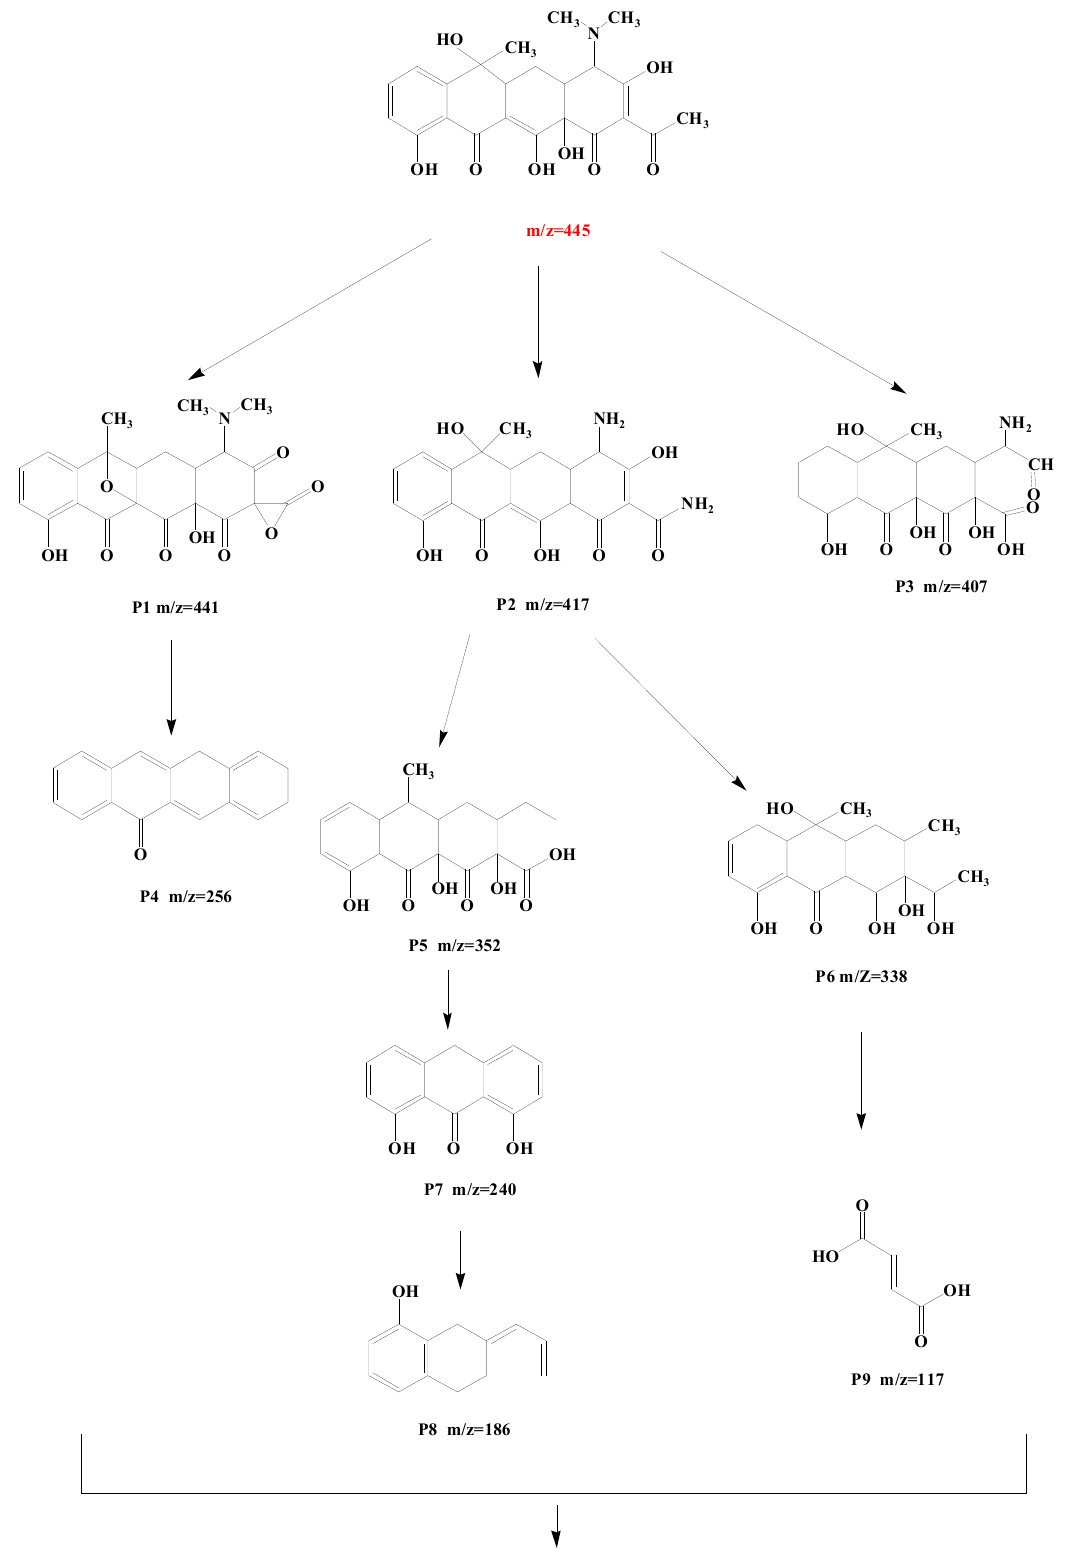
Figure 12. Possible TC degradation pathway by 9%Co-CNK-OH.